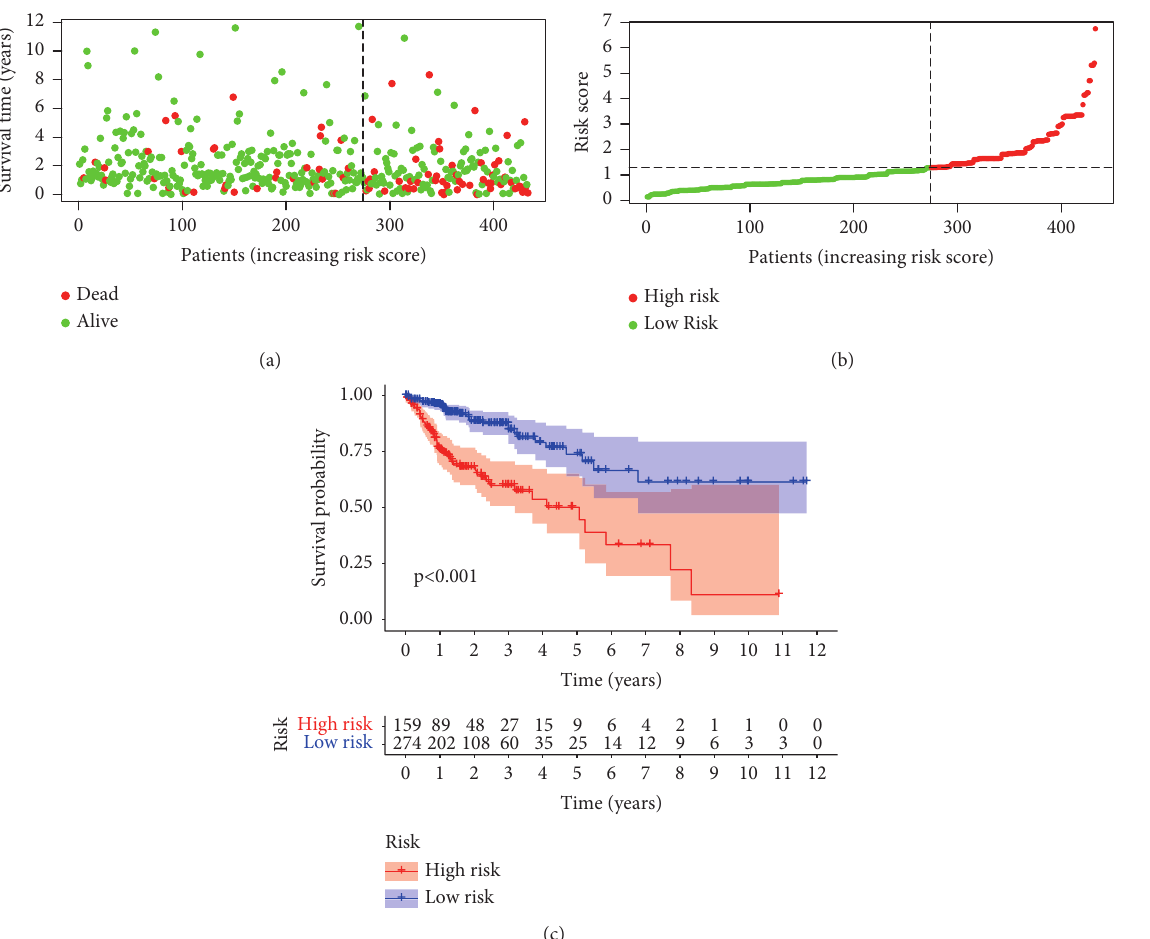
Figure 5: (a) Distribution of risk scores. (b) Distribution of survival outcomes. (c) Survival outcomes based on Kaplan–Meier survival